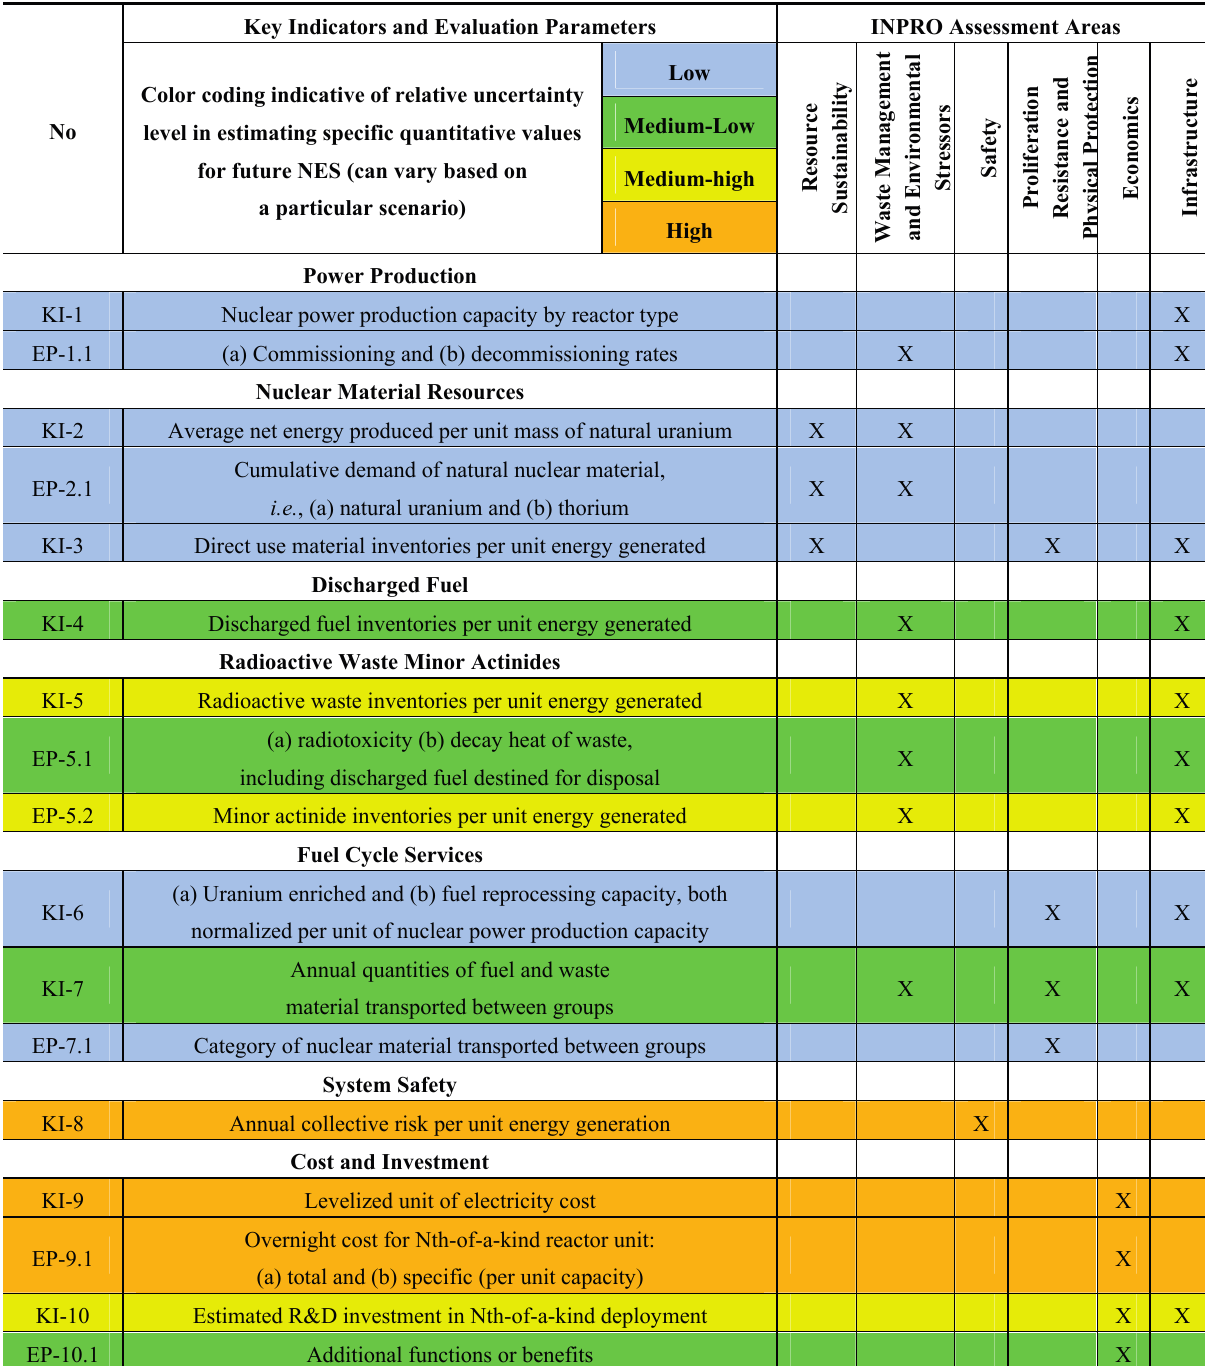
Table 1. The GAINS key indicators and evaluation